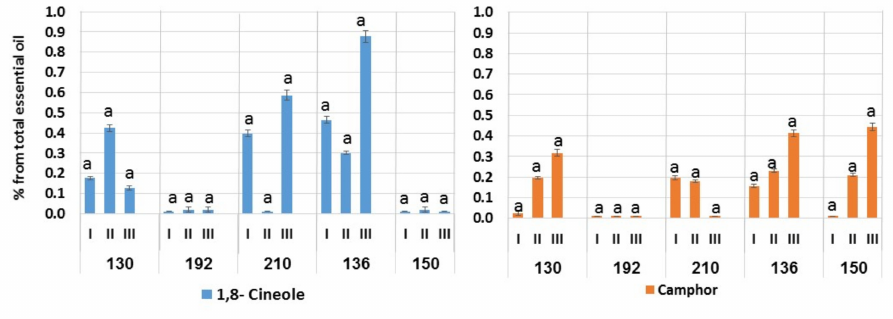
Figure 2. Dynamics of accumulation of valuable minor components in the essential oil of plants in the cultivars of A. balchanorum 130, 192, 210, 136, and 150. I—vegetative stage: during the spring regrowth at the end of May 2019, the entire annual shoots were sampled; II—flower buds: the tops of the stems with closed buds were sampled in mid-October 2019; III—flowering: the tops of the stems with inflorescences were sampled in mid-November 2019. Each compound was analyzed separately in each cultivar for the differences between the stages. Bars represent standard deviation. One-way ANOVA and Student’s t -test were applied. Levels not connected by the same letter are significantly different ( α =